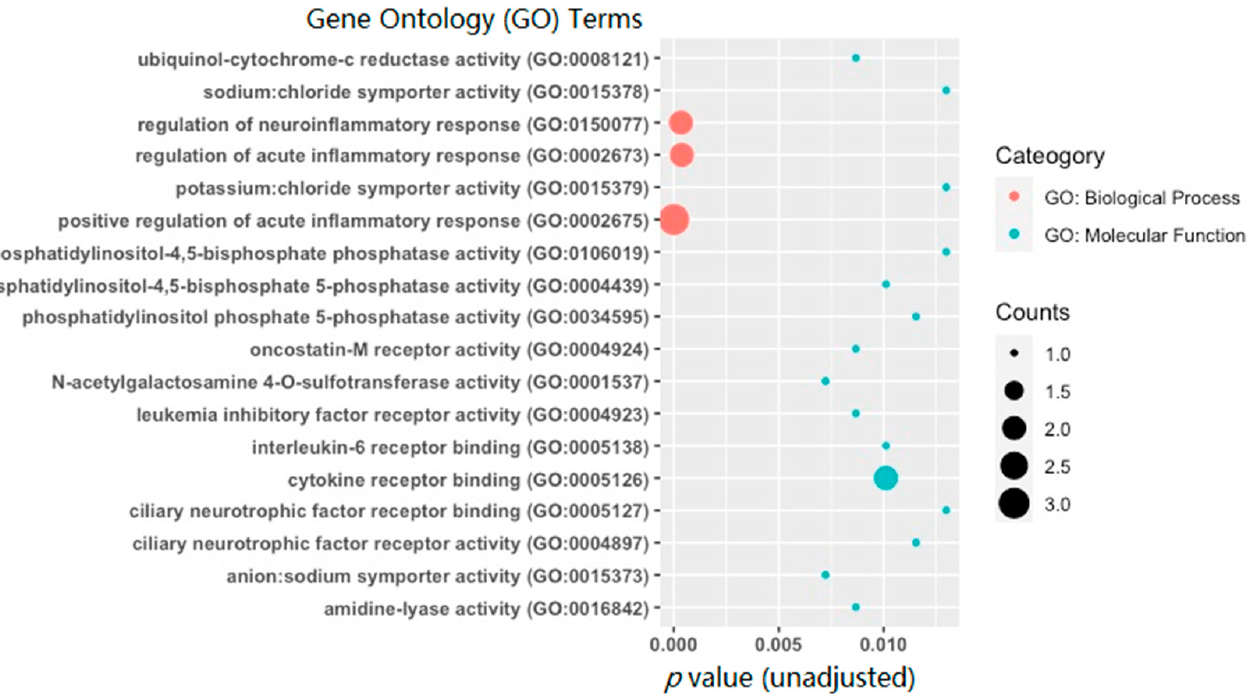
Figure 4. A bubble plot of the top 18 Gene Ontology (GO) terms (adjusted p < 0.05) obtained by enrichment analysis of differentially methylated mRNAs (|FC| ≥ 2 and p -value < 0.05). GO terms are color-coded by subcategory (biological process vs. molecular function). The size of the bubble for each enrichment term corresponds to the number of enriched genes within that GO term.